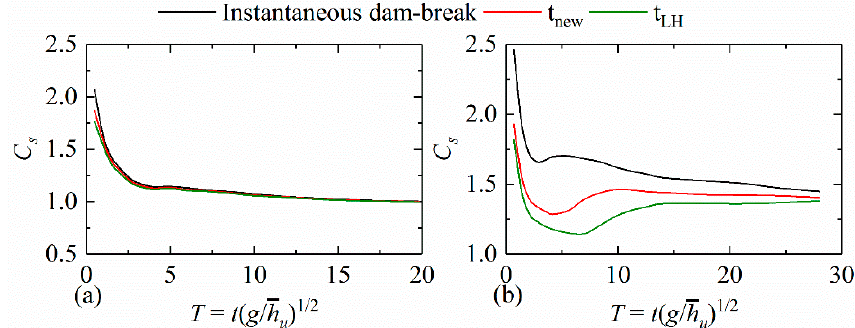
Figure 8. Front velocity for different criterion: ( a ) A rectangular channel; ( b ) a triangular